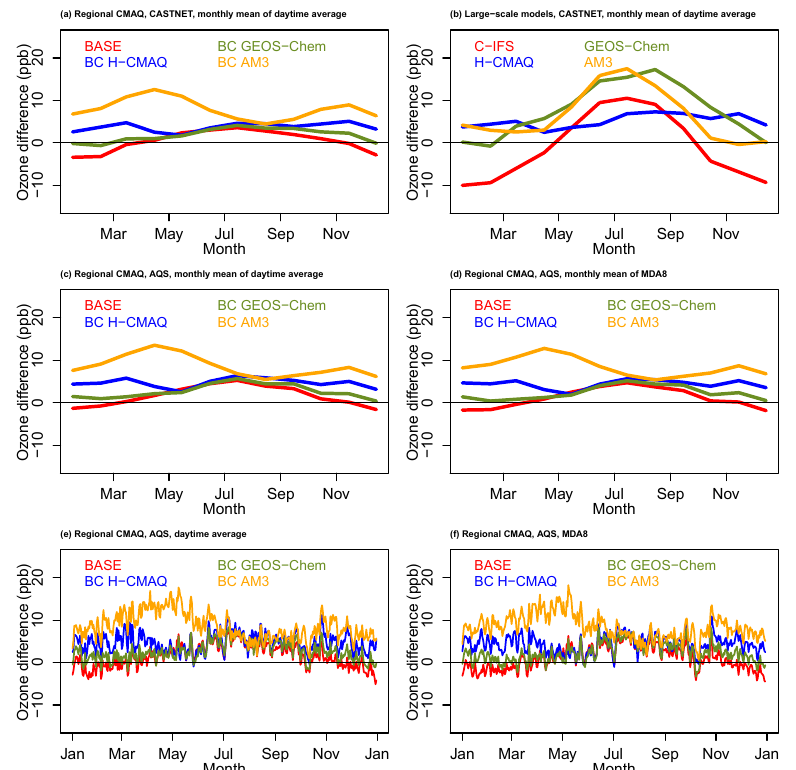
Figure 11. Time series of differences between modeled and observed ozone mixing ratios. (a) Monthly means of daytime average mixing ratios at CASTNET monitors for regional model simulations, panel (b) is the same as (a) but for large-scale models, panel (c) is the same as (a) but for AQS monitors, panel (d) is the same as (c) but for monthly means of MDA8 instead of monthly means of daytime average mixing ratios, panel (e) is the same as (c) but for daily daytime average mixing ratios, and panel (f) is the same as (d) but for daily